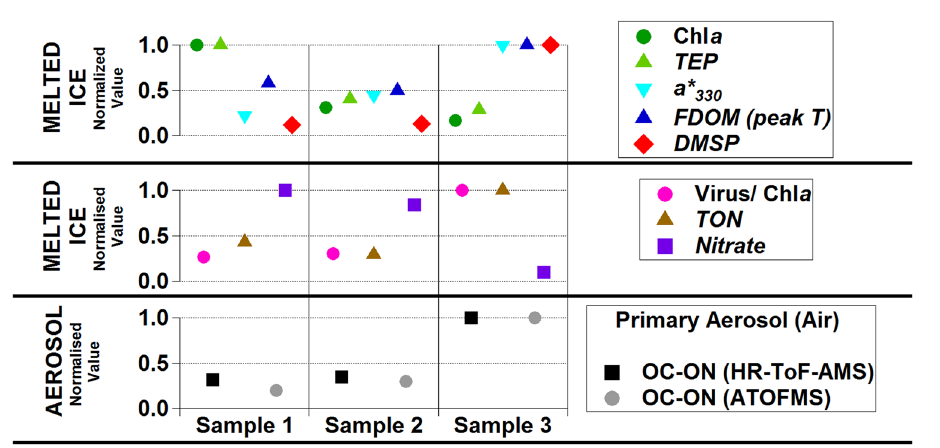
Figure 4. Concentrations in melted sea ice samples and the corresponding sprayed aerosols. Three ice samples were melted and analysed for a number of variables: Chl a is chlorophyll a ; TEP is transparent exopolymer particles; a * 330 is light absorption at 330 nm corrected for baseline absorption, corresponding to the concentration of mycosporine-like aminoacids (MAA); FDOM peak T is the fluorescence of organic matter at the excitation/emission wavelengths 280/350 nm; DMSP is dimethylsulphoniopropionate; TON is total (particulate + dissolved) organic nitrogen; OC-ON is mixed organic carbon and nitrogen; HR-ToF-AMS is high-resolution time-of-flight aerosol mass spectrometry; ATOFMS is aerosol time-of-flight mass spectrometry. For the clarity of comparisons, all values are normalised to the